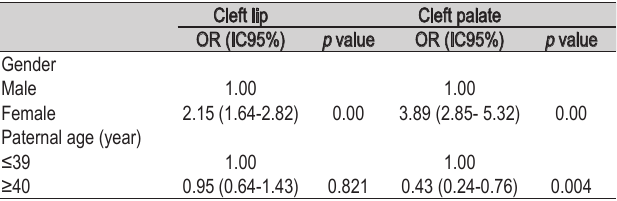
Table 4 - Multinomial logistic regression analysis. Distribution of cleft lip and cleft palate according to gender and paternal age, with reference to the cleft lip and cleft